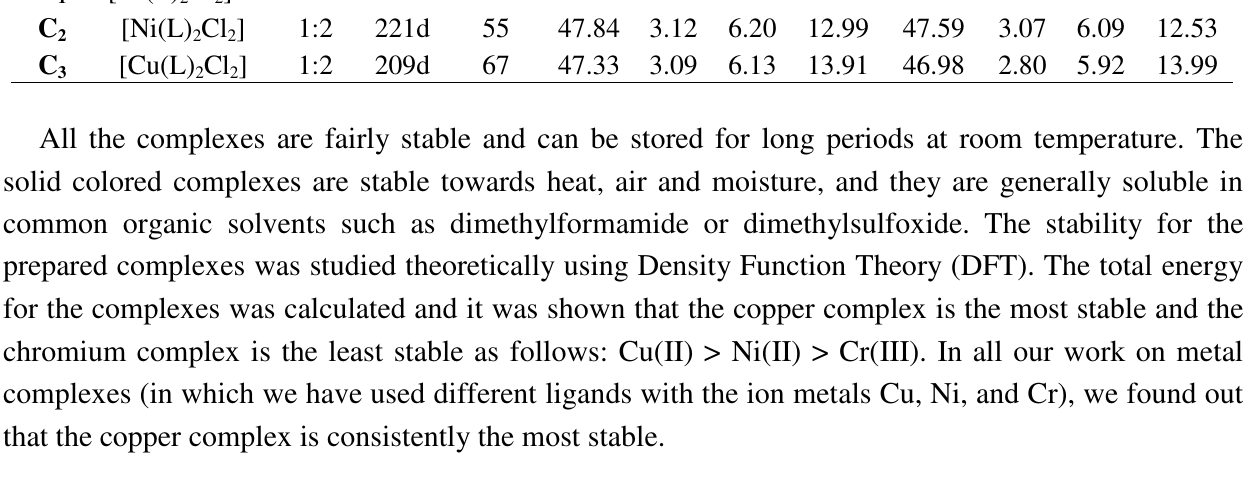
Figure 3. The proposed structure for the